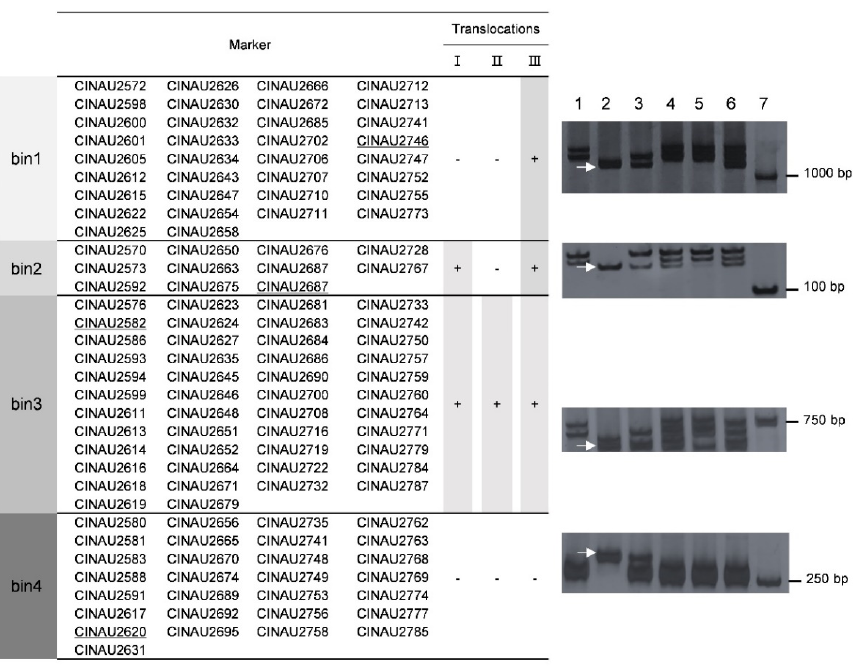
Figure 5. Development of IT markers and construction of a cytogenetic physical map of H. villosa 6VS chromosome arm. Left: Molecular markers in each bin. Right: The amplification results of representative markers in each bin which was underlined in the left. 1: T. aestivum (AABBDD); 2: H. villosa (VV); 3: T. aestivum – H. villosa translocation line (T6VS·6AL); 4–6: Three T. aestivum – H. villosa small fragment translocation lines (NAU418, NAU419 and NAU1203); 7: DNA Ladder.